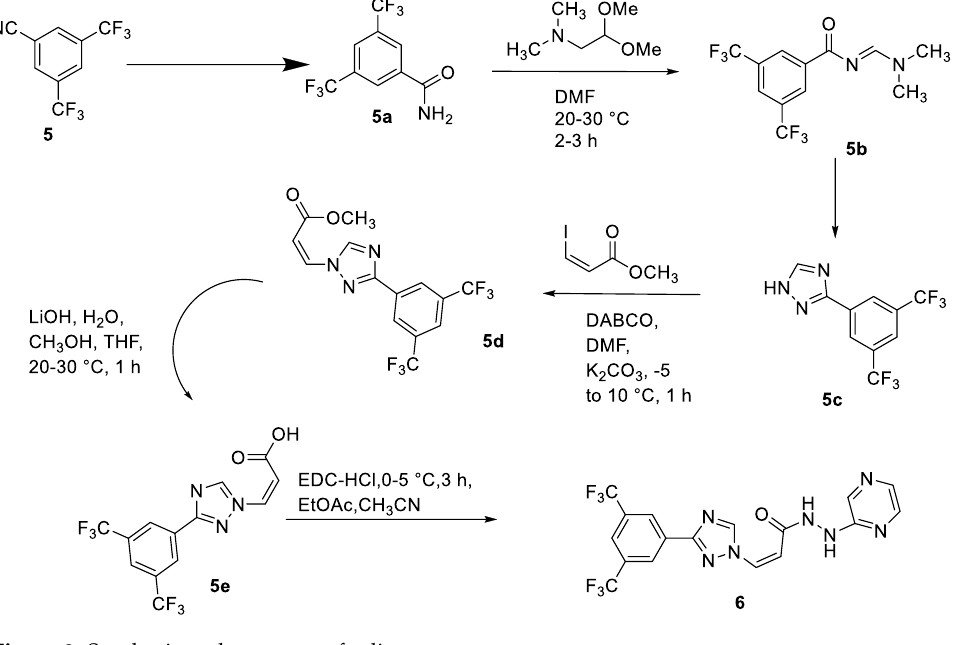
Figure 3. Synthesis and structure of selinexor.